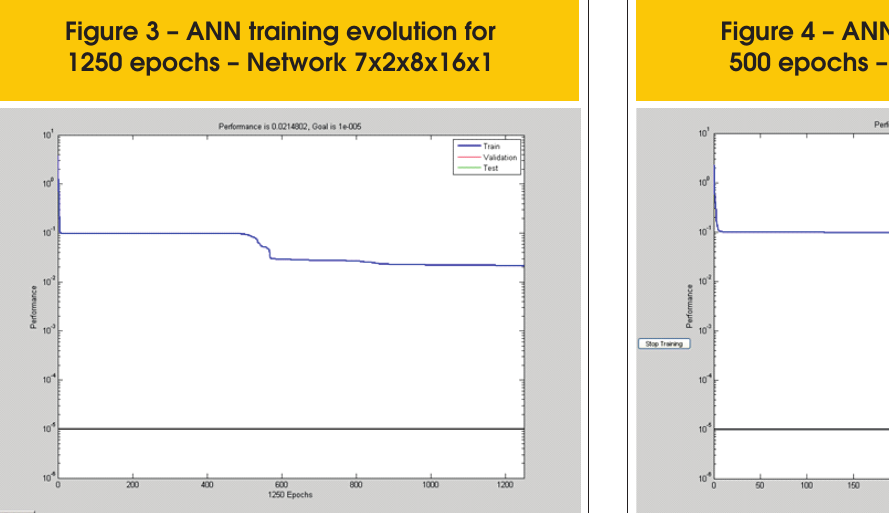
Figure 3 – ANN training evolution for Figure 4 – ANN training evolution